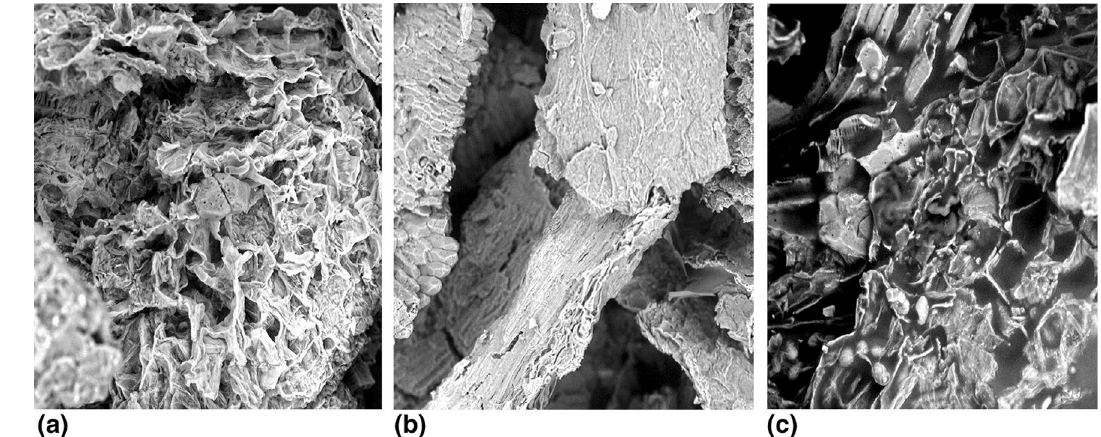
Fig. 2 SEM micrograph for unmodified ( a ), modified ( b ) and crude oil-treated ( c ) CP Fig. 3 FTIR spectra for unmodi- fied [green (1) spectra] and modified [red (2) spectra] and crude oil-treated [black (3) spectra] OPEFB